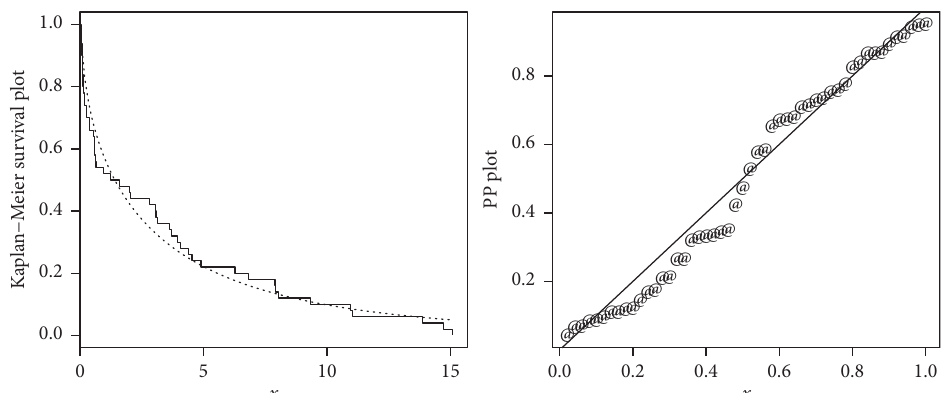
Figure 12: Plots of the PP and the Kaplan–Meier survival function of the NGE-Weibull